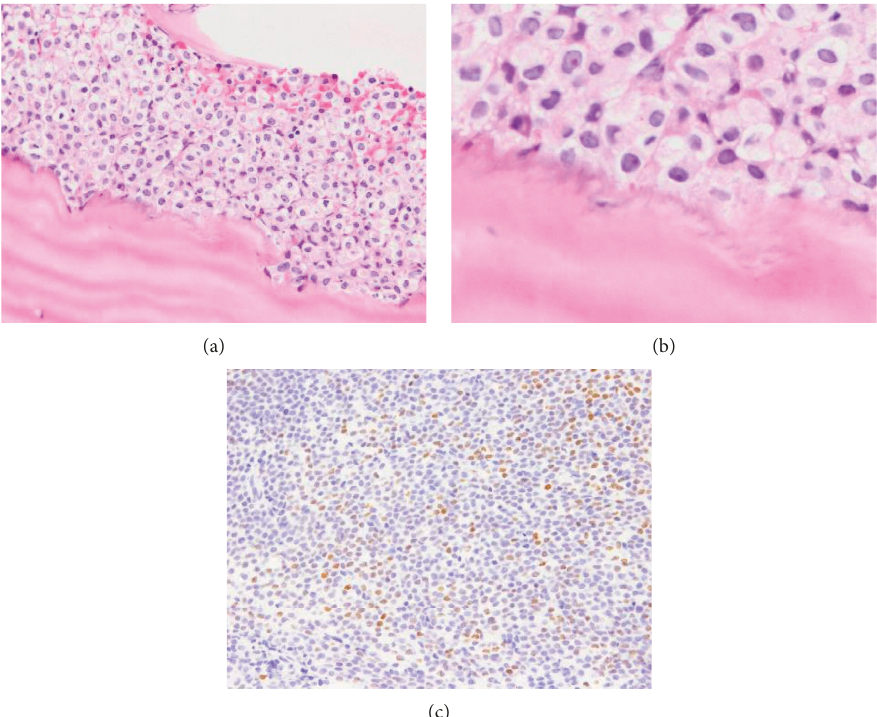
Figure 5: Histopathology of bone marrow biopsy at diagnosis. (a)-(b) Hematoxylin-Eosin stain showed that the bone trabecula border in contact with leukemic cells shows osteolysis-like appearance. (a) Magnification, 100x; (b) magnification, 400x; (c) parathyroid hormone- related protein stain. Positive cells were stained brown. Magnification,